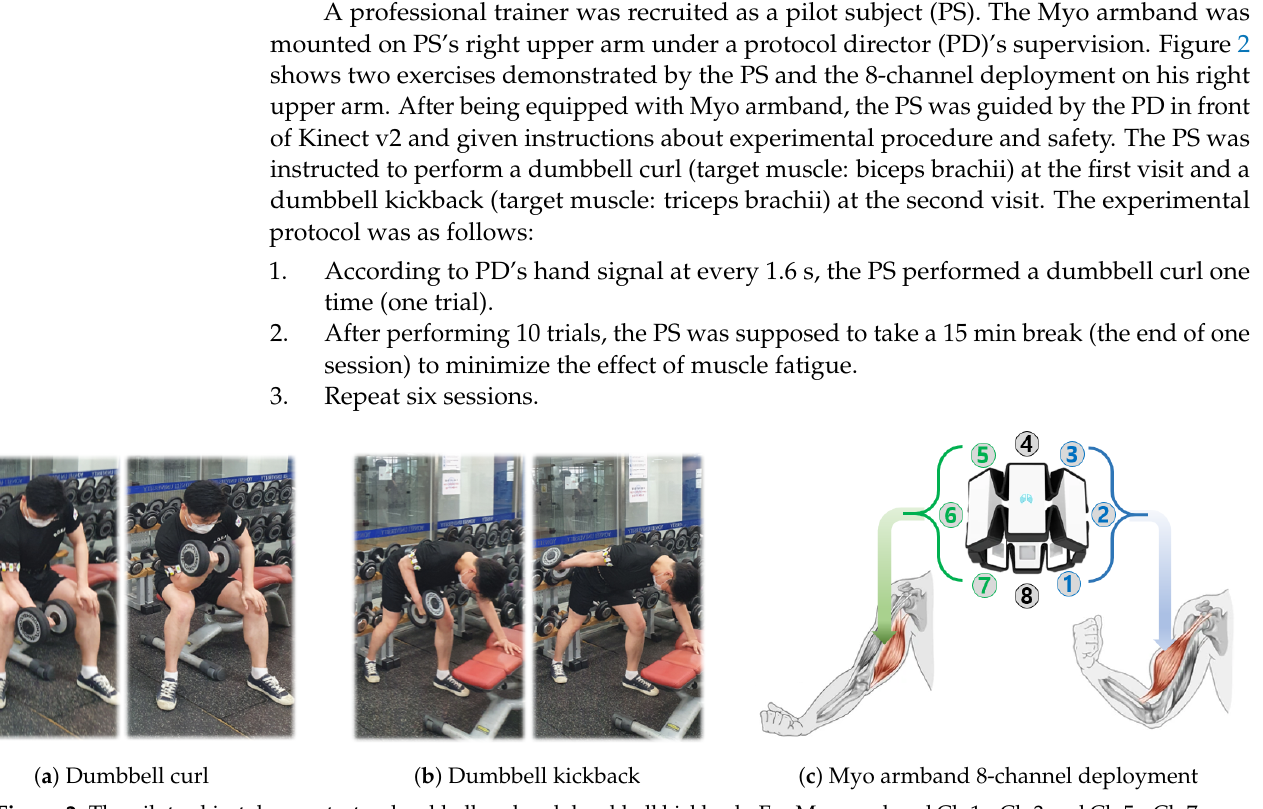
Figure 2. The pilot subject demonstrates dumbbell curl and dumbbell kickback. For Myo armband Ch.1 ∼ Ch.3 and Ch.5 ∼ Ch.7 correspond to biceps and triceps brachii, respectively. Ch.4 and Ch.8 are placed on boundaries between two